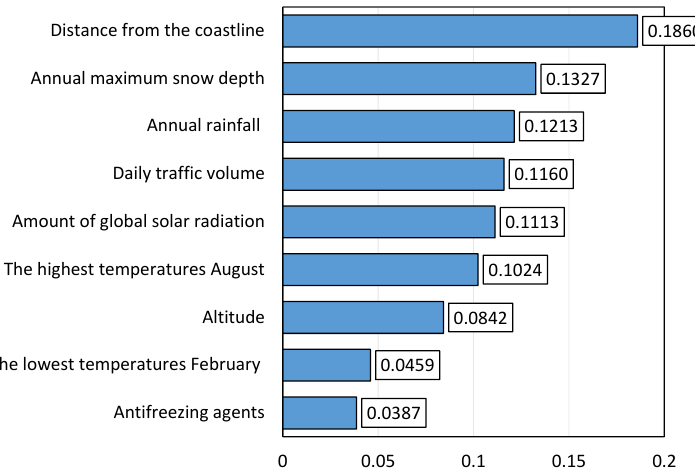
Figure 16. Range in concrete beams that have been in service for 30–40 years.